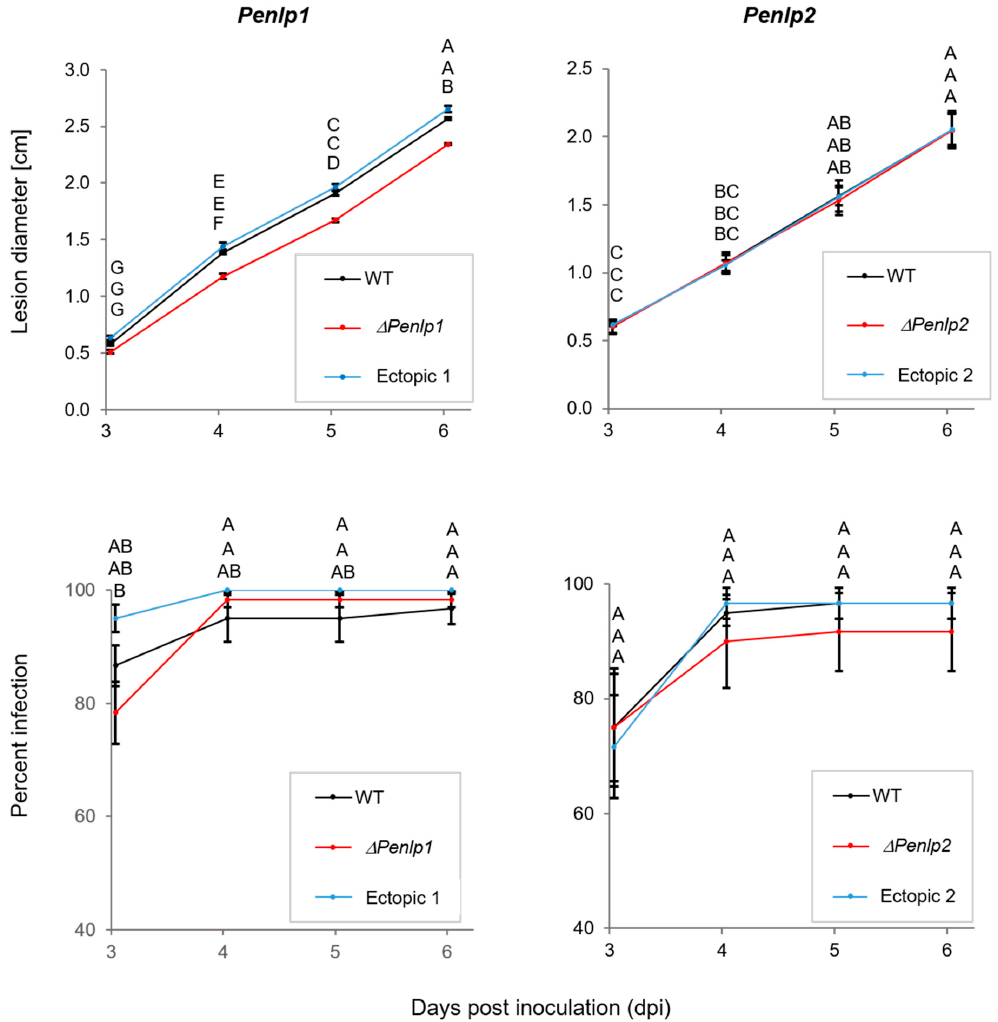
Figure 5. ‘Golden Delicious’ apples were inoculated with wild-type and transformant strains to examine pathogenicity. Fruits were wounded and 10 µL of spore suspension (10 5 conidia/mL) were added into each wound. For each treatment fifteen fruits with four wounds per fruit were used. Decay diameter and percentage of infected wounds were measured at 3, 4, 5, and 6 dpi. Results of one of three independent experiments are presented. Bars indicate standard error. Letters indicate significant differences at p < 0.05 based on nested one-way ANOVA followed by Tukey’s honest significant difference (HSD) test.3.5. Penlp1 and Penlp2 Knockout Mutants of P. expansum .